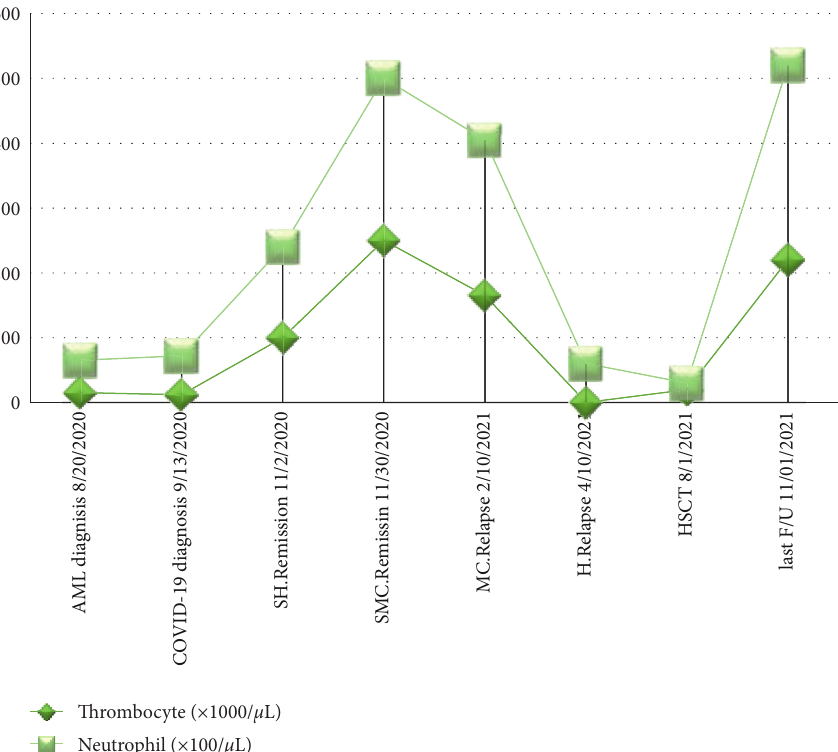
Figure 4: Blood cell changes and the time point of COVID-19 diagnosis, spontaneous remission, and relapse during the course of disease. SH.Remission, spontaneous hematologic remission; SMC.Remission, spontaneous molecular cytogenetic remission; H.Relapse, hema- tologic relapse; MC.Relapse, molecular cytogenetic relapse; HSCT, hematopoietic stem cell transplantation; and F/U,